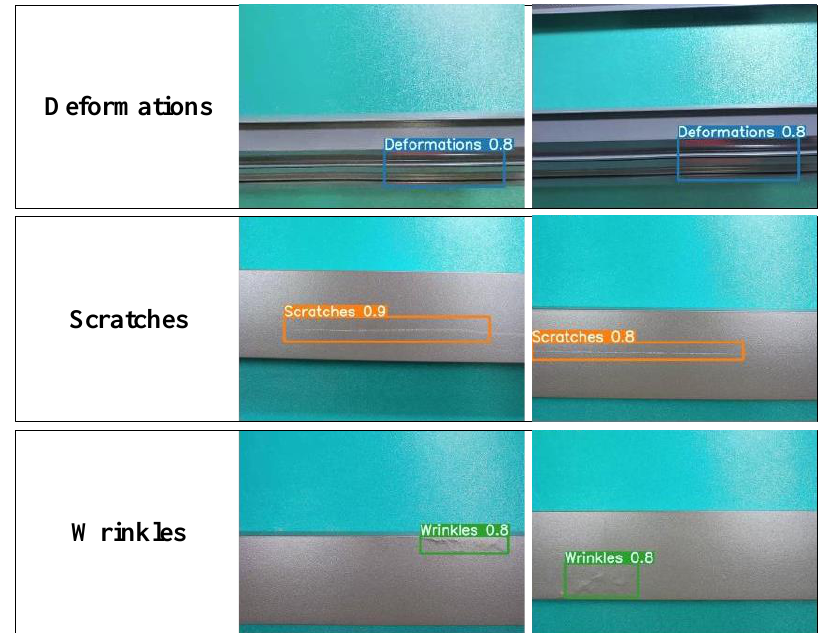
Figure 10. Detection effect of the algorithm in this